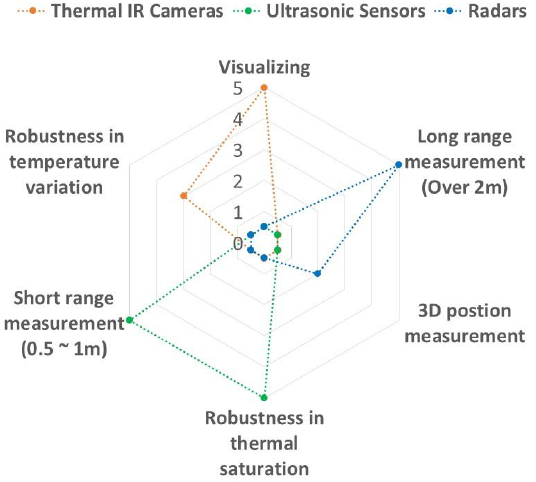
Figure 3. Characteristics of suitable sensors for use in dense smoke: Thermal IR cameras, Ultrasonic sensors, and Radars